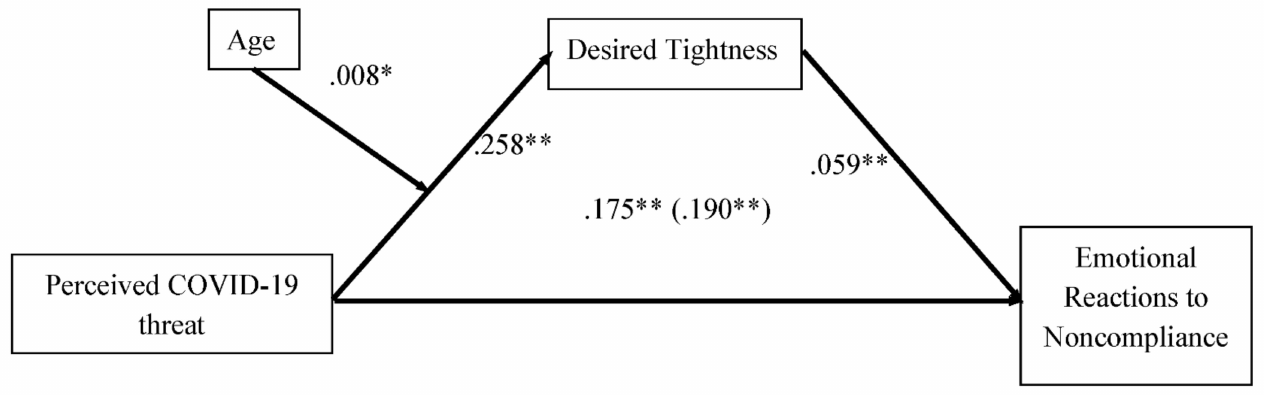
Figure 2. Moderated mediation results. Note. The total effect of perceived COVID-19 threat is in parentheses. All results are unstandardized. ** p < 0.01; * p <